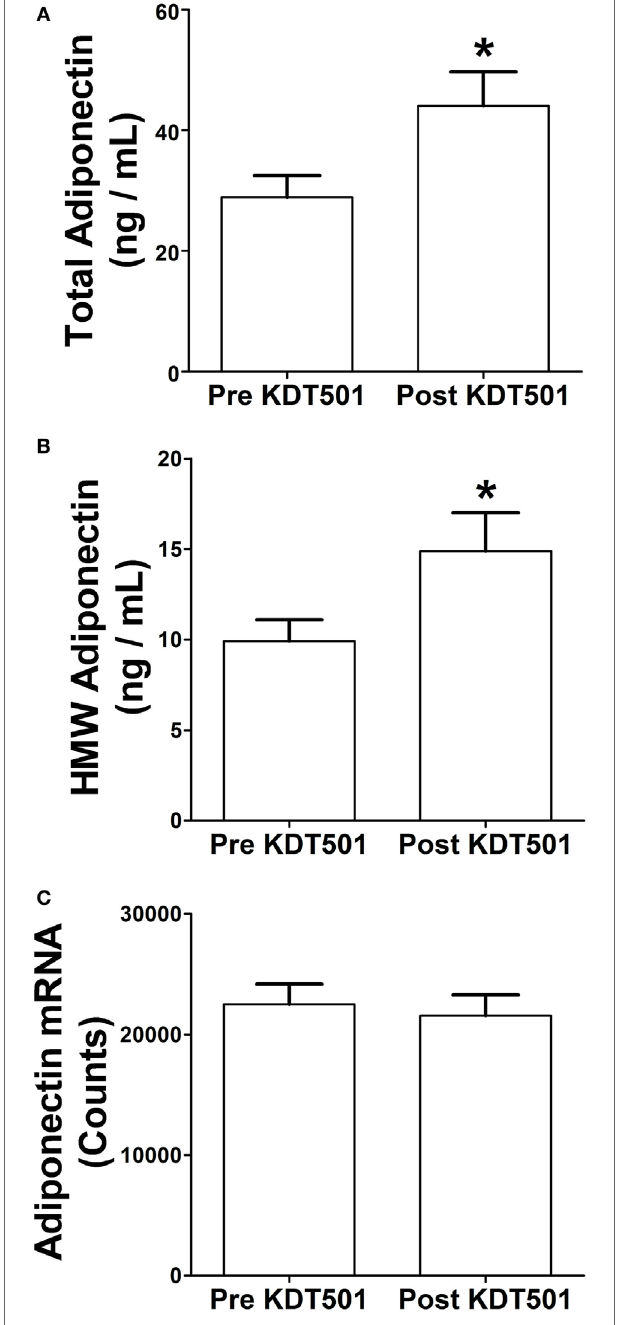
FiGUrE 1 | KDT501 induces total and high-molecular weight (HMW) adiponectin secretion by adipose tissue explants from obese, insulin-resistant subjects. Adipose tissue explants obtained before and after KDT501 treatment were incubated in Dulbecco’s modified Eagles’ medium (DMEM) for 1 h at 37°C. (a) Total and (B) HMW adiponectin concentrations in the DMEM were measured by ELISA and are expressed as the concentration/g adipose/h. (C) Adiponectin gene expression was measured in the corresponding adipose tissue biopsy with the Nanostring nCounter system as described in the Section “Materials and Methods.” Data represent the mean ± SEM ( n = 9); data in all panels were analyzed by a paired, two-tailed Student’s t -test (* P <